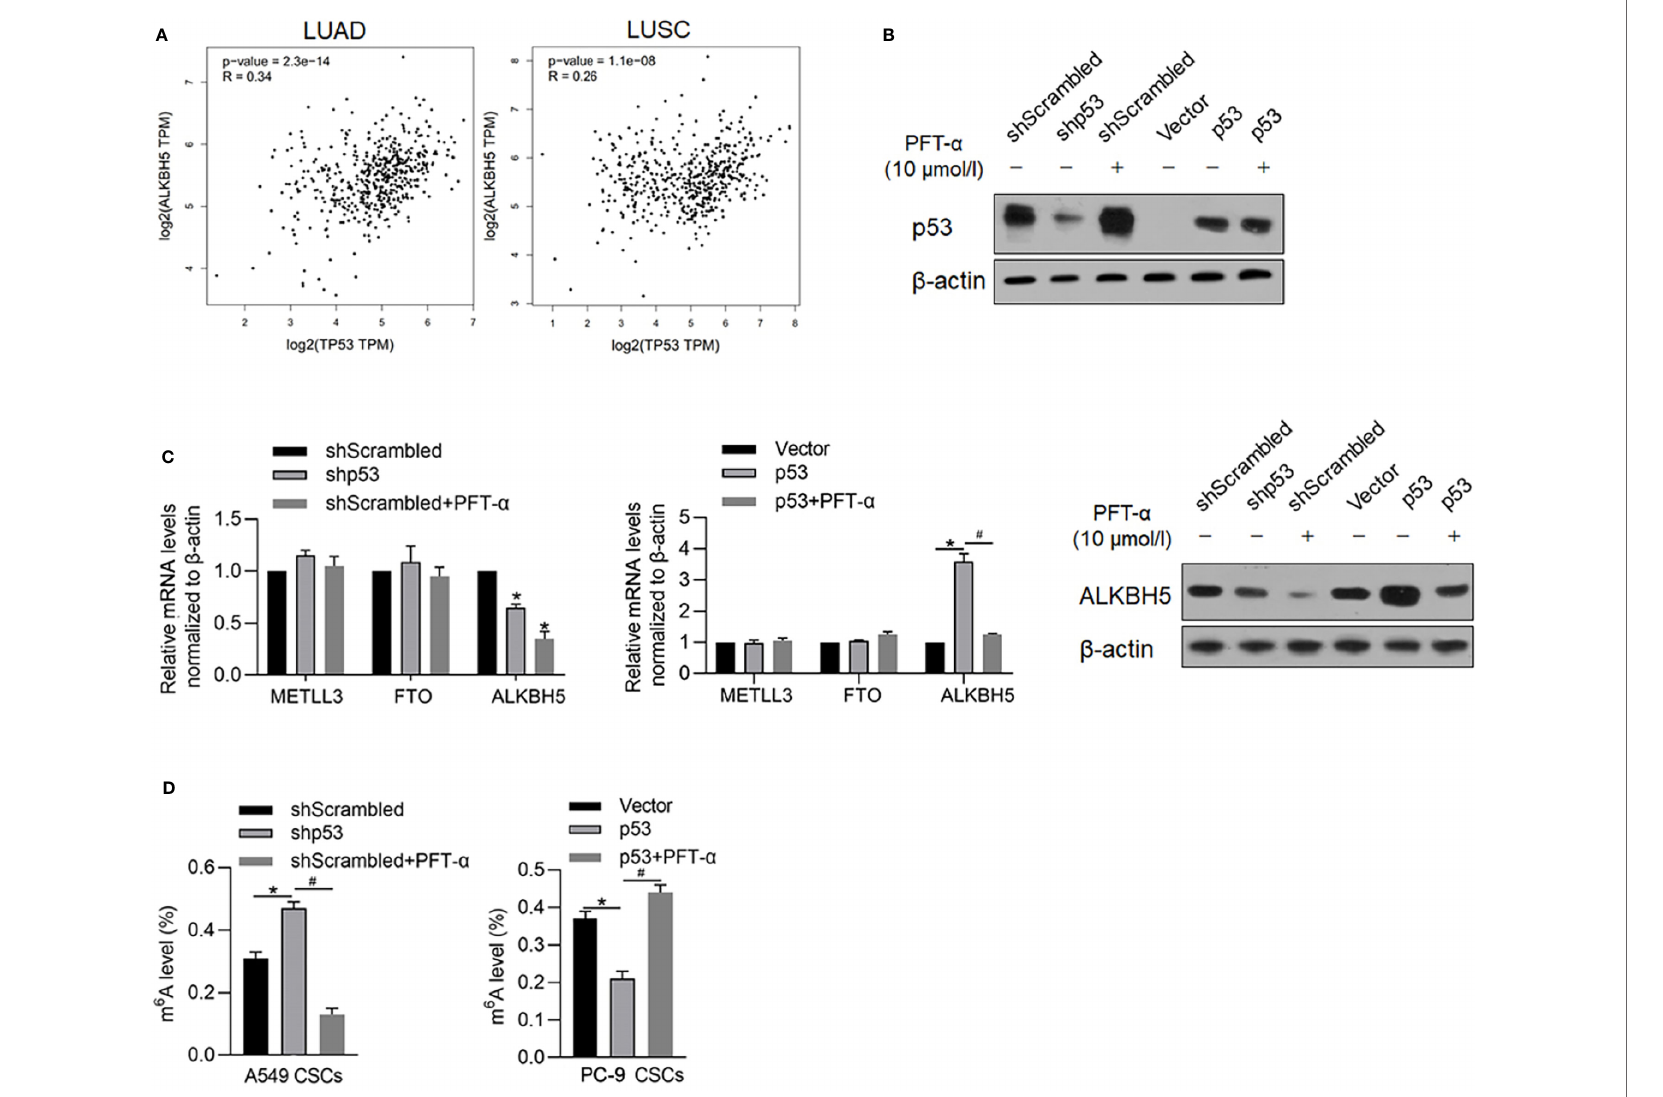
FIGURE 6 | p53 transcriptionally regulates ALKBH5 and subsequently decreased m 6 A methylation. (A) GEPIA database analysis tool was used to compare the correlation between ALKBH5 and p53 in LUAD and LUSC. (B) In A549 and PC-9 CSCs, the ef fi ciency of p53 knockdown or overexpression was measured by performing a Western blot analysis. (C) After modi fi cation of p53 with or without PFT- a , ALKBH5 mRNA and protein level were measured. * p < 0.05 vs. shScrambled group; # p < 0.05 vs. p53 group. (D) After modi fi cation of p53 with or without PFT- a , m 6 A methylation level was measured. * p < 0.05 vs. shScrambled group; # p < 0.05 vs. shp53 group (left panel); * p < 0.05, vs. vector group; # p < 0.05 vs. p53 group (right